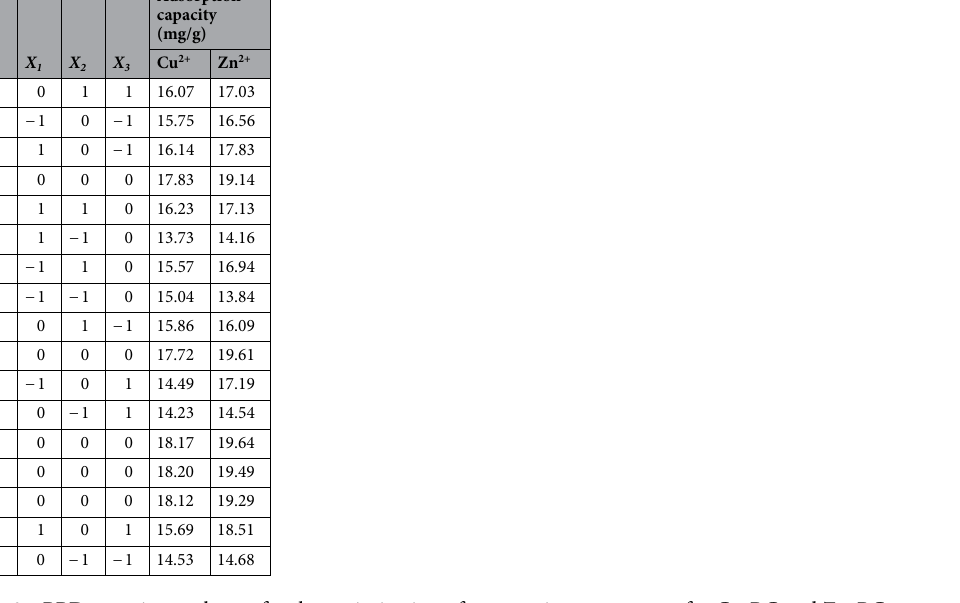
Table 2. BBD experimental runs for the optimization of preparation parameters for Cu-BC and